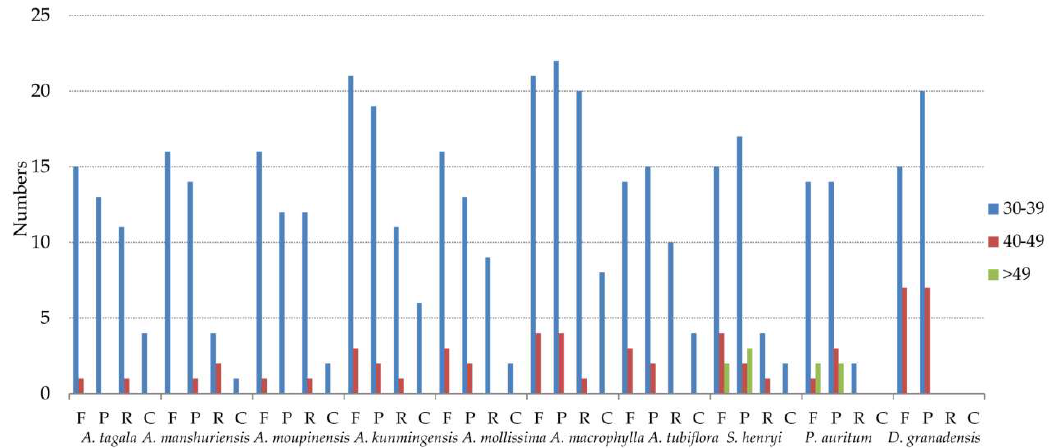
Figure 5. Repeat sequences in ten cp genomes. REPuter was used to identify repeat sequences with length ≥ 30 bp and sequence identity ≥ 90% in the cp genomes. F, P, R, and C indicate the repeat types F (forward), P (palindrome), R (reverse), and C (complement), respectively. Repeats with different lengths are indicated in different colors.